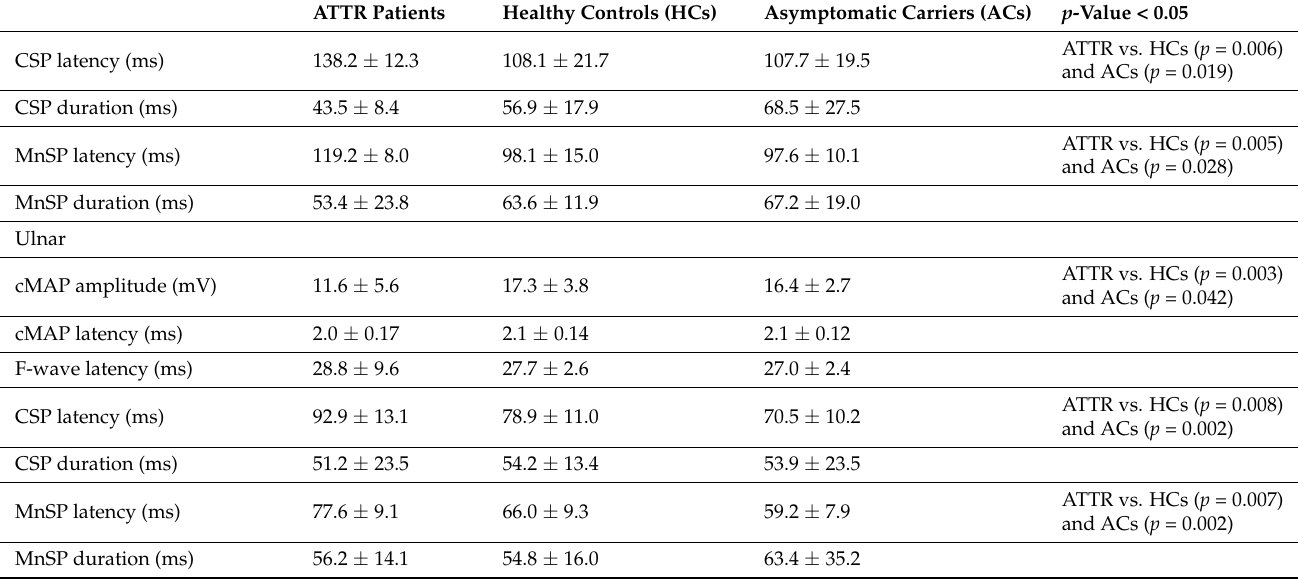
Table 2. Cont . ATTR Patients Healthy Controls (HCs) Asymptomatic Carriers